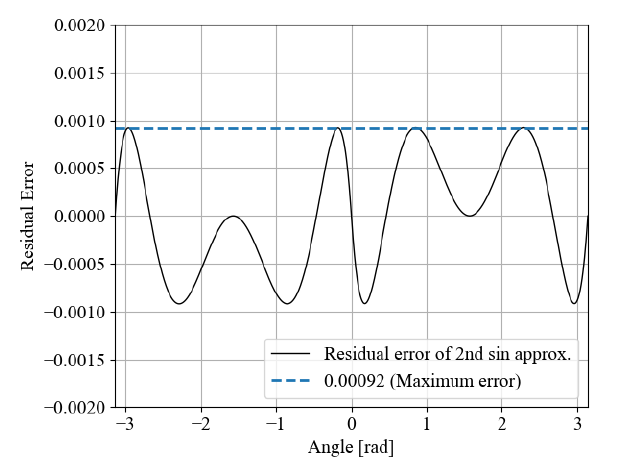
Figure 4. Residual error of 2nd approximation of sin-function. Table 1. Calculation time evaluation of 2nd approximations of sin-function and cos-function (Aver- age ± S.D.). 1st Approx. 2nd